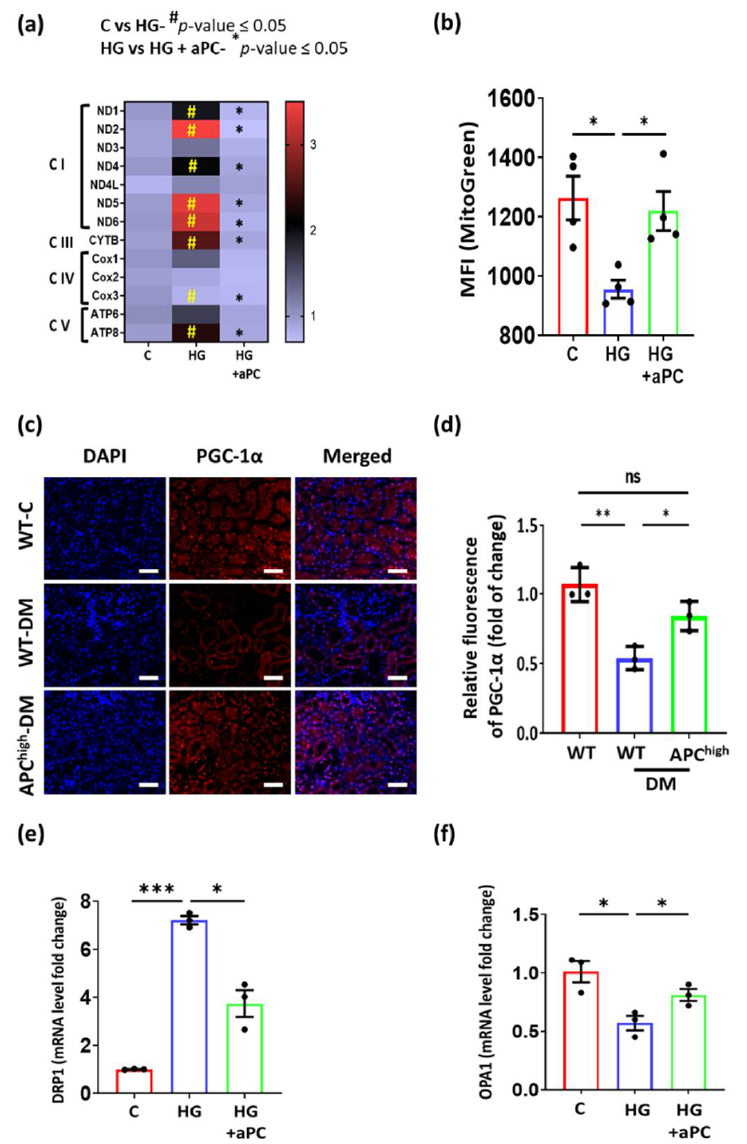
Figure 2. aPC protects against mitochondrial dysfunction in DKD. ( a ) Heatmap summarizing the mRNA expression (quantitative RT–PCR) of genes related to mitochondrial ETC complexes. Five samples per group were analysed, and the colour key represents the fold change. ( b ) Bar graph with dot-plot summarizing staining intensity (mean fluorescent intensity, MFI) of the mitochondrial mass marker MitoTracker Green in tubular cells without (C) or with (HG) exposure to high glucose (25 mM, 24 h). A subgroup of cells was pretreated with aPC (20 nM, 1 h: HG + aPC). ( c , d ) Representative immunohistochemical images ( c ) and bar graph with dot plot summarizing results ( d ) of PGC-1 α staining (red, DAPI nuclear counterstain, blue) in mouse kidneys from nondiabetic wild-type (WT-C), diabetic wild-type (WT-DM), or diabetic APC high mice (APC high -DM), scale bar: 20 µ m. ( e , f ) Bar graph with dot-plot summarizing Drp1 ( e ) and Opa1 ( f ) mRNA levels in control (normal glucose, 5 mM) and high glucose (25 mM)-treated BUMPT cells without (HG) or with aPC pretreatment (20 nM, 1 h, HG + aPC); * p < 0.05; ** p < 0.01; *** p < 0.001; ns = non-significant ( a , b , d – f ). Statistical analyses were performed using one-way ANOVA with Sidak’s multiple comparison test. aPC = activated protein C; C = control; DM = diabetes mellitus; DRP1 = dynamin-related protein 1; HG = high glucose; MFI = mean fluorescent intensity; OPA1 = Optic atrophy 1; WT =